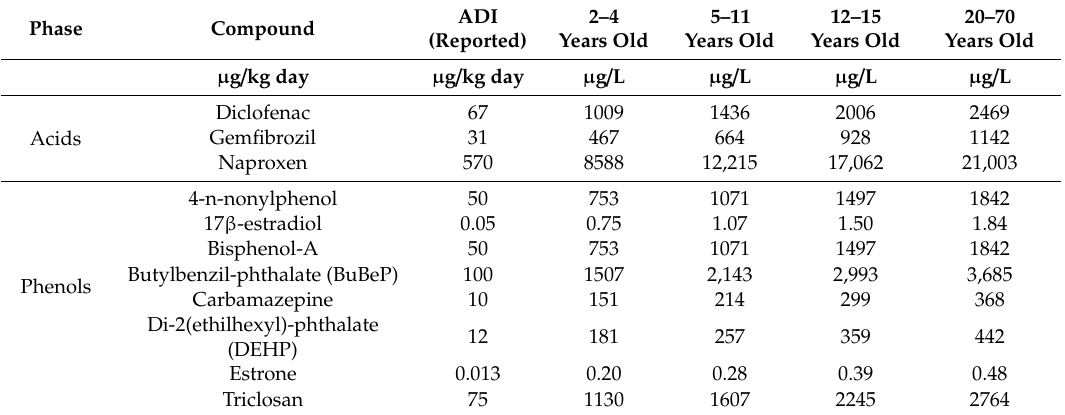
Table 6. Drinking water equivalent levels (DWELs) for Mezquital Valley groundwater.